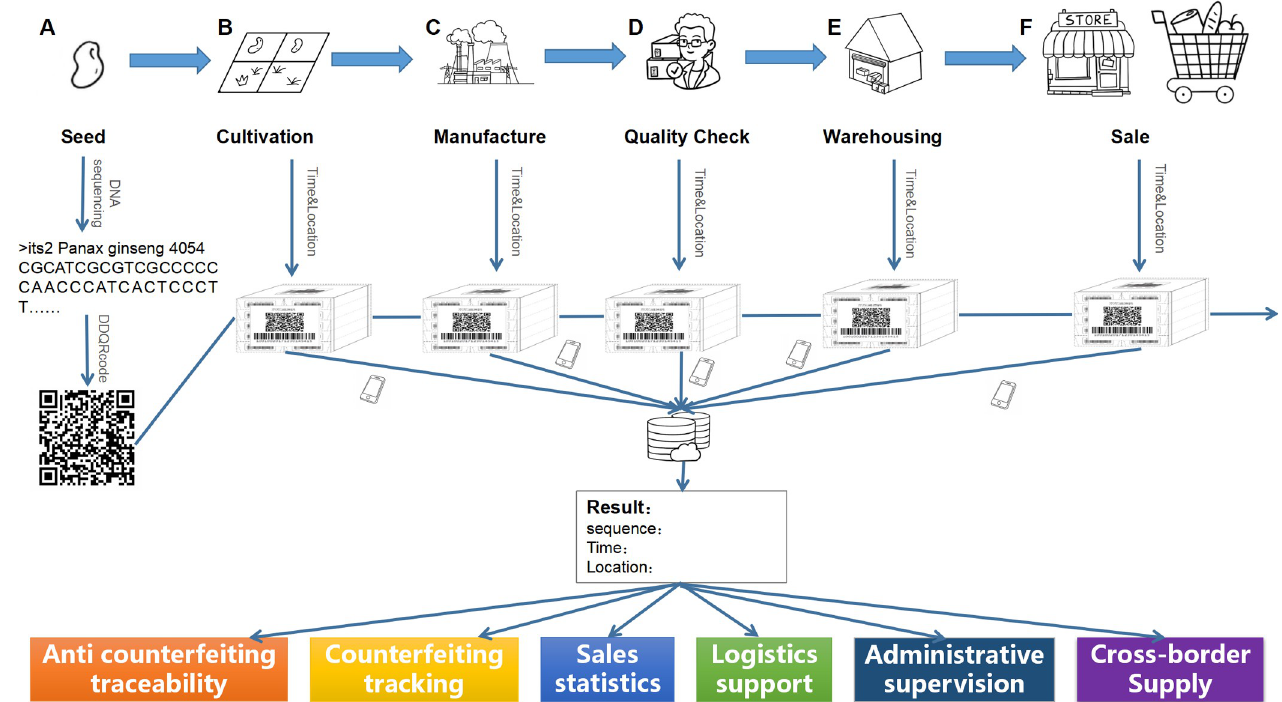
Fig 8. Exemplary usage of DDQR in the supply chain for various applications. Starting from a seed (A), its DNA sequence can be obtained and encoded into a DDQR code. The DDQR code would then be printed as a label that will be associated with the plant materials through the different points of the supply chains, including but not limited to cultivation (B), manufacture (C), quality check (D), warehousing (E), and sales (F). At each point, the DDQR code can be scanned. At the same time, the time and location at which the DDQR code is scanned will be recorded into a central database. The sequence, time, and location information can be retrieved to support various applications as